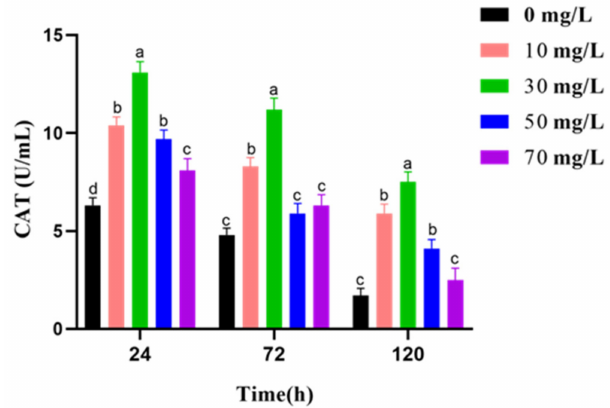
Figure 3. E ff ect of grape seed procyanidin extracts (GSPE) on the CAT activity of goat sperm of preserved at 4 ◦ C. Within the same incubation time, values with di ff erent superscripts di ff er among treatments ( p < 0.05). The values are expressed as mean ± SEM.